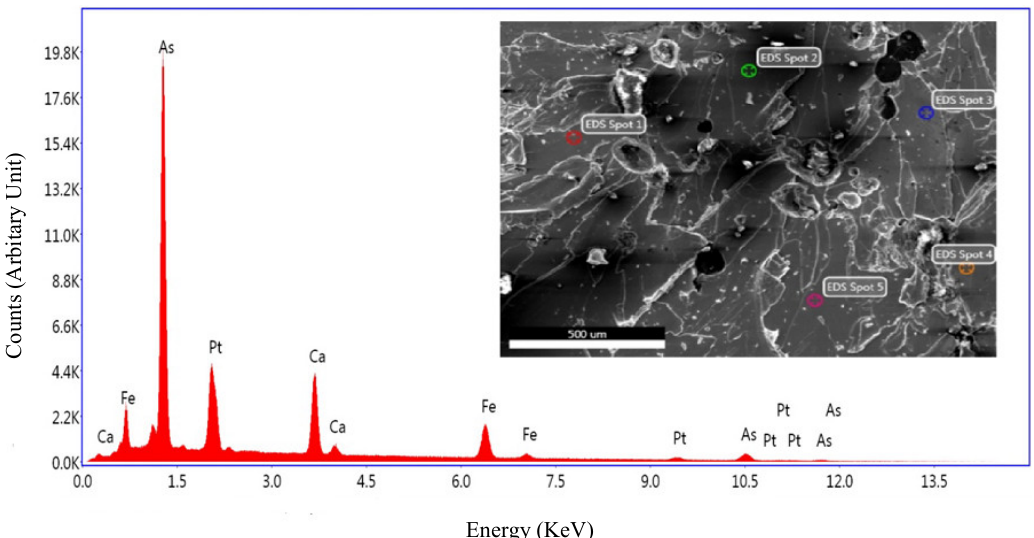
Figure 2. EDX measurement spectrum of Ca 10 Pt 5.4 Fe 8.6 As 18 ; the inset figure is a surface SEM image of the measured sample.